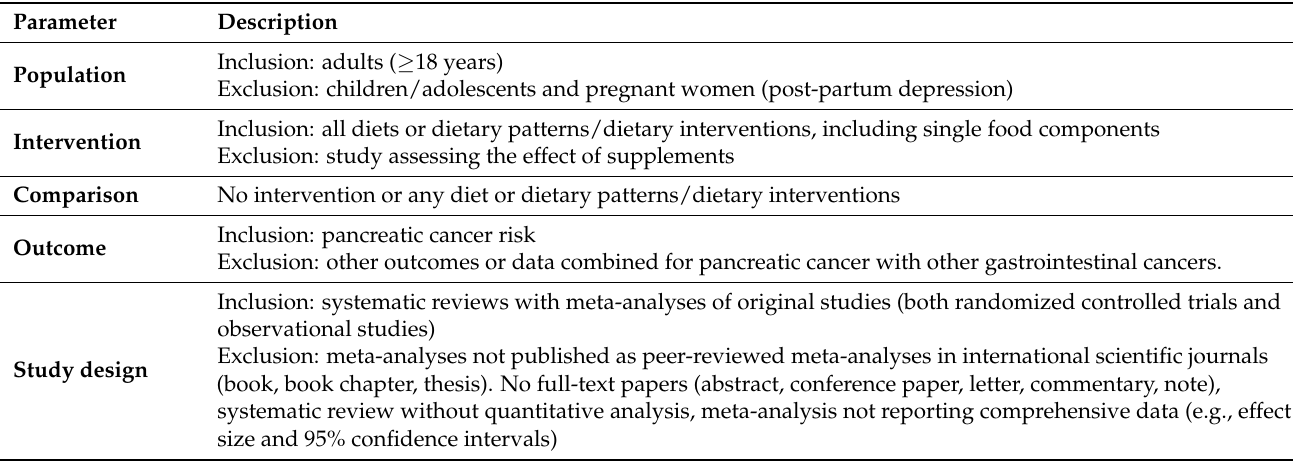
Table 1. PICOS criteria used in the present umbrella